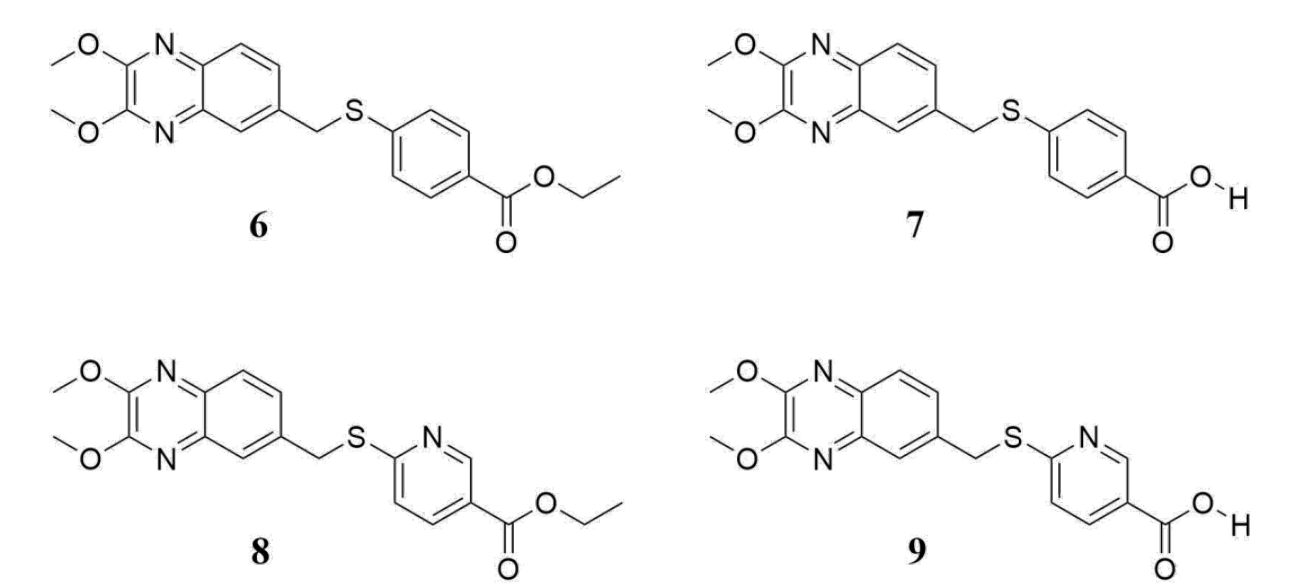
Figure 1. Chemical structure of quinoxaline derivatives 6 – 9 selected for deeper antiviral investigation. They are labeled as previously reported [16].